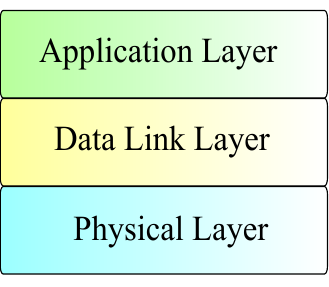
Figure 20. Field-bus functional layers. transfers data between adjacent network nodes. Other Field-bus protocols are possible on di ff erent Data Link layer such as Token and